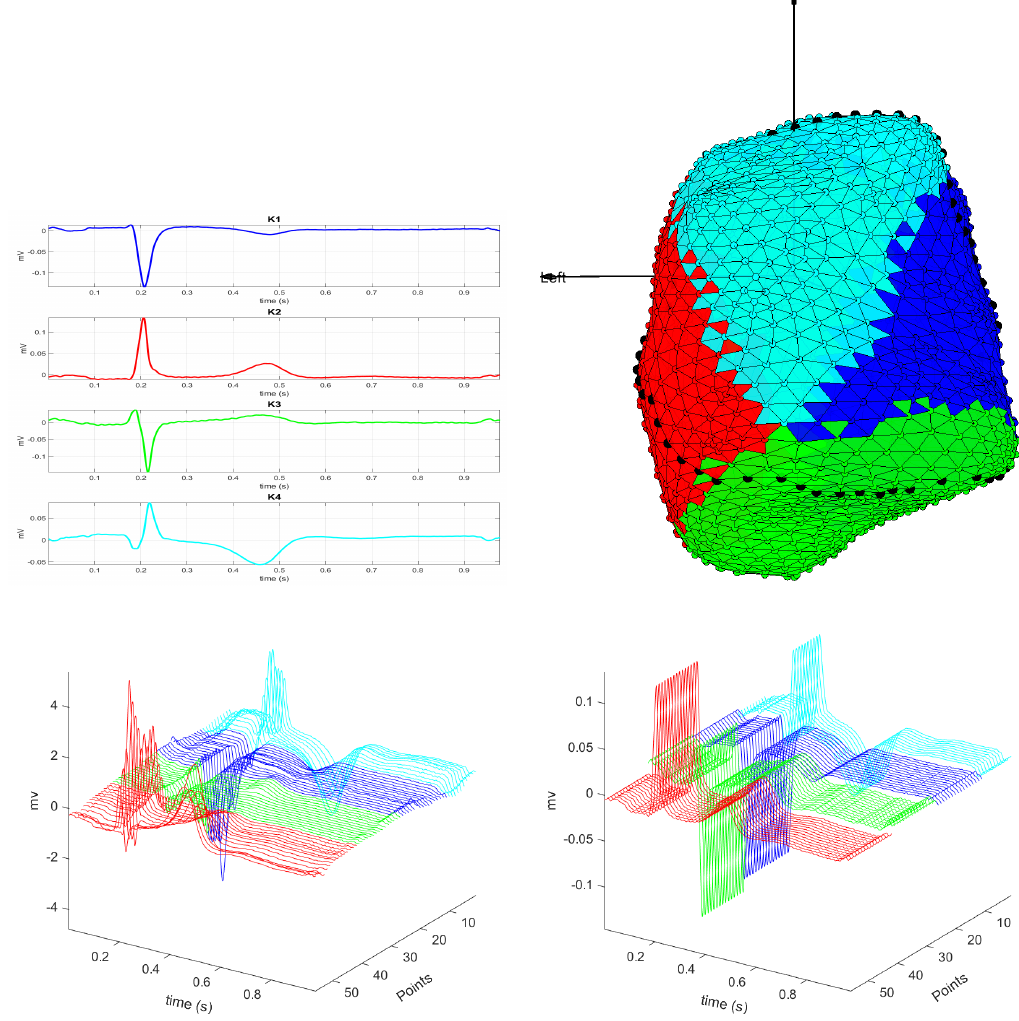
Figure 7. Control cases. Unipolar EGM, using cosine distance with K = 4. ( Up ) Centroids of each class and clustering map. ( Down ) M-mode of the unipolar EGM for the dotted line, and M-mode of their corresponding